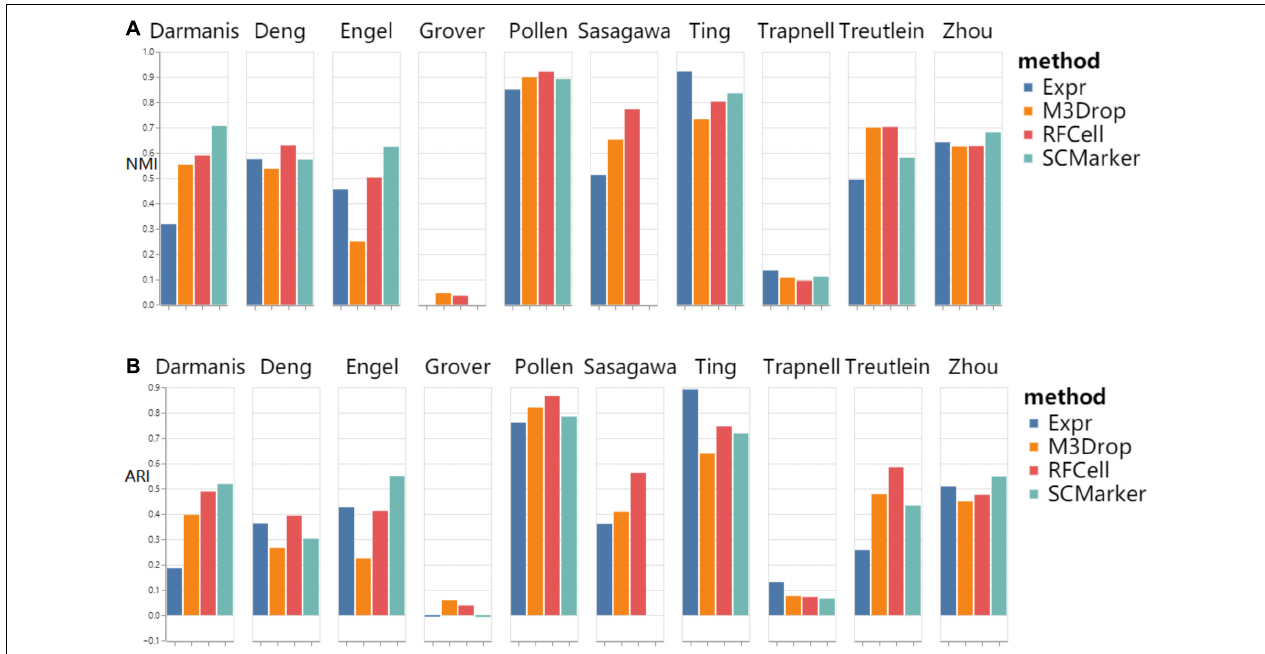
FIGURE 3 | k-means clustering results based on RFCell and three gene selection methods including Expr, M3Drop, and SCMarker in terms of NMI (A) and ARI (B) .